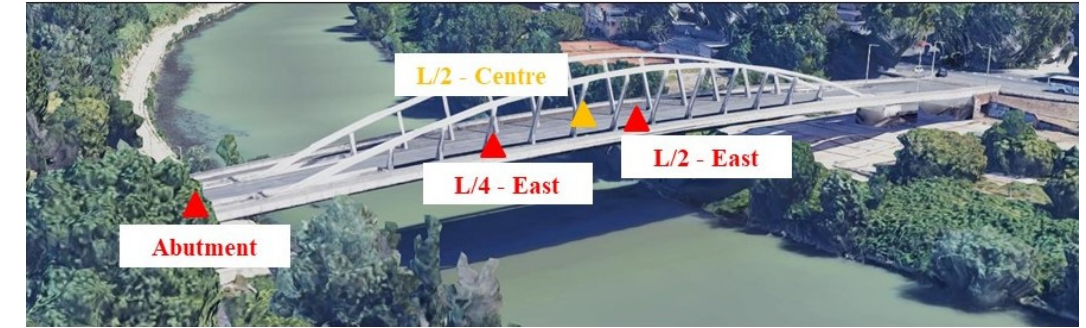
Figure 10. Locations of the ambient vibration recordings.